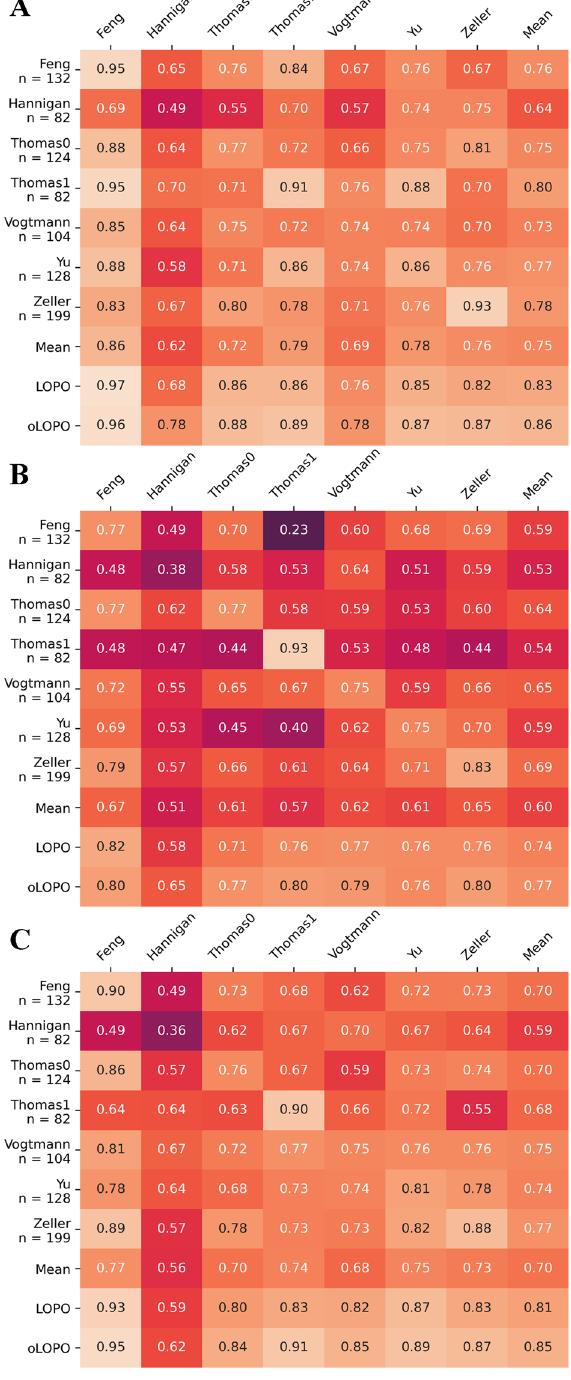
Figure 4. Cross-prediction matrix that measures the performance of the proposed model in terms of the area under the receiver operating characteristic curve (AUROC) for ( A ) taxonomic, ( B ) KEGG and ( C ) eggNog metagenomic profiles. The diagonal represents the intra-project performance by reporting the mean of the AUROC of 20-times tenfold cross validation, whereas the off-diagonal shows the cross-dataset performance, i.e. train with the model indicated in the rows and test over the project in the columns. Finally, the Leave one Project Out (LOPO) row reports the performance of predicting the dataset referred to in the columns while training with the other datasets, whereas the oLOPO row is the same experiment but using the functional signature learned during the LOPO